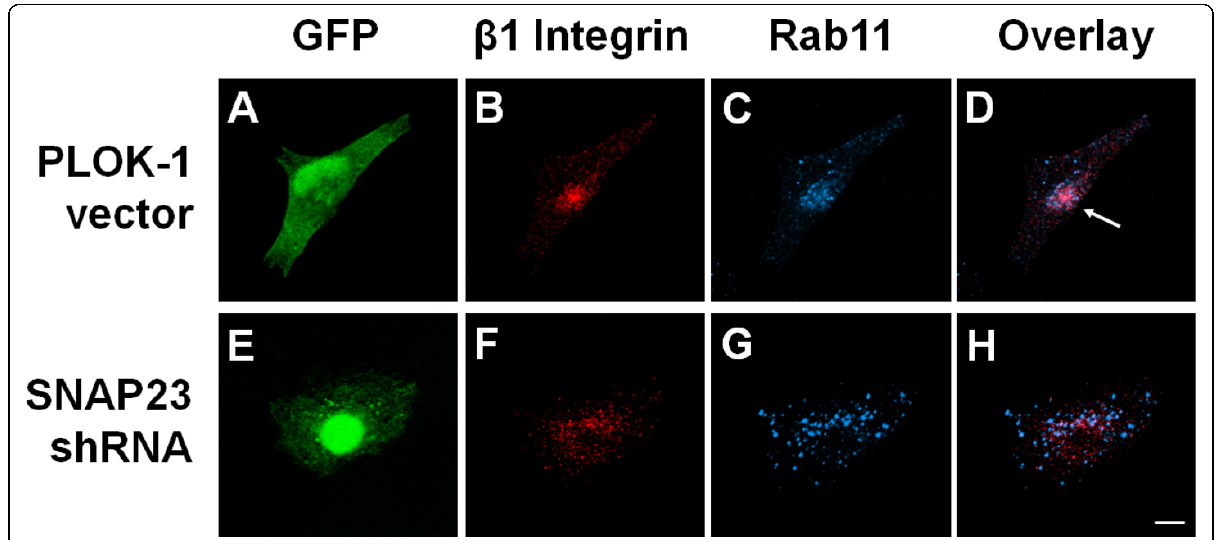
Figure 6 shRNA-mediated downregulation of SNAP23 disrupts b 1 integrin trafficking into the recycling endosome . Hela cells were transiently transfected for 72 h with GFP + PLOK-1 vectror [A-D] or GFP + vector containing SNAP23-targeting shRNA [E-H]. Cells were labeled with anti- b 1 integrin antibody in serum free media for 1 h to allow internalization of integrin-antibody complexes. Cells were then washed in 0.2 M glycine, pH 2.5, fixed, and stained for the intracellular integrin-antibody complexes [B, F] and Rab11 [C, G]. Overlays of the Rab11 and b 1 integrin staining are shown in D and H. Arrows indicate conventional colocalization of b 1 integrin in a central Rab11-containing compartment. Images are 3 D reconstructions of a z-series. Scale bar represents 10 μ